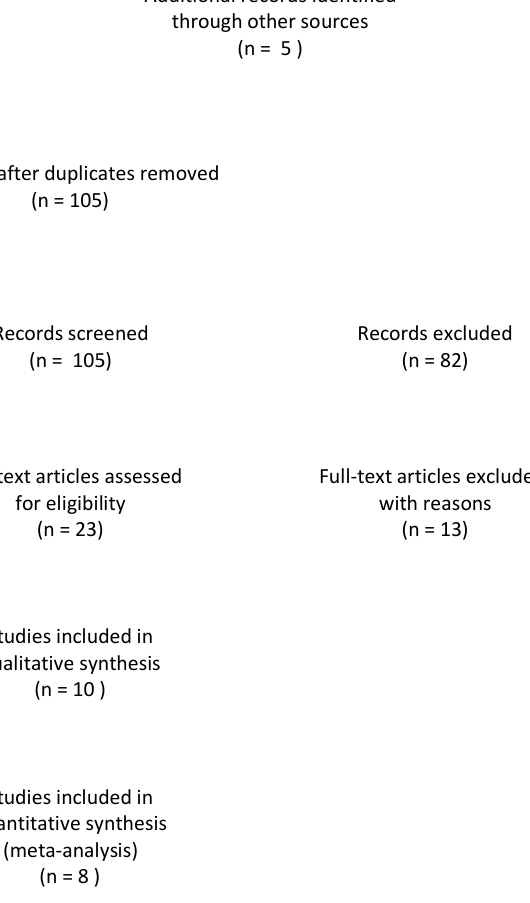
Figure 1. PRISMA flow chart [30].